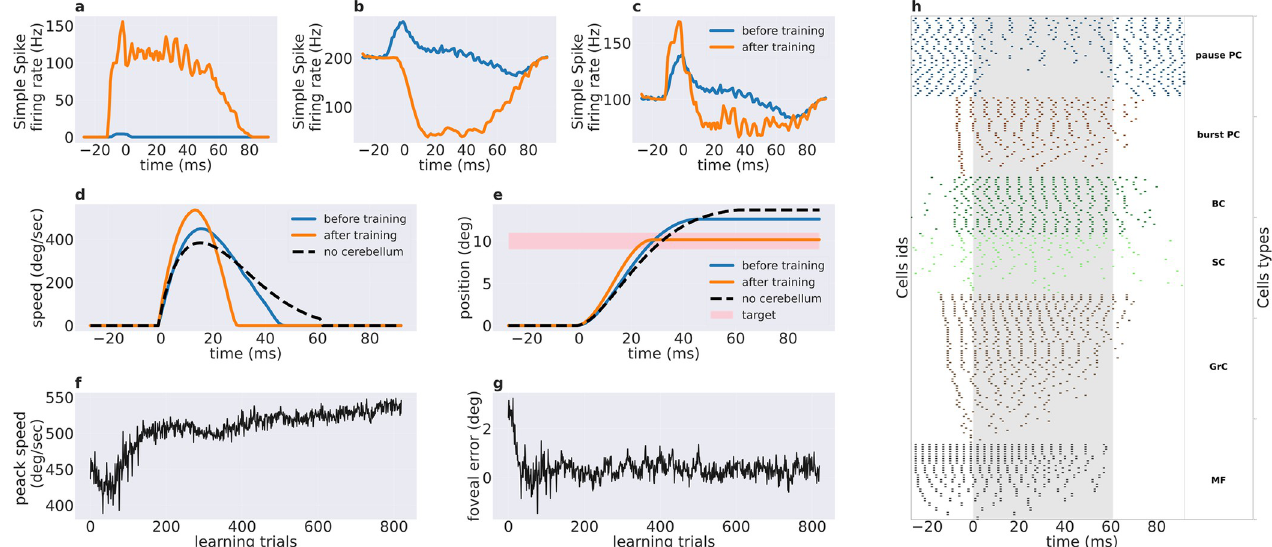
Fig 2. Effect of cerebellar learning by dual PF-PC plasticity mechanisms on the behavioral and neural variables. Simple spike firing rate: a) burst PC subpopulation. b) pause PC subpopulation, c) all PCs together. In these panels, the simple spike activity before training is shown in blue while the one after training is shown in orange. t = 0 ms corresponds to the onset of the eye movement. Eye movement kinematics: d) saccade speed and e) displacement of the eye model before training, after training and without cerebellum in blue, orange, and dashed-black. The pink rectangle represents the target within accuracy limits of +-0.5 degree. t = 0 ms corresponds to the onset of the eye movement. Movement properties across trials: f) Peak speed, g) end foveal error. h) Raster plot of the spiking activity of all cerebellar neuron populations in the model. The dots correspond to a single spike of the given cell, where the cell type is denoted in the right column. The eye movement starts at t = 0 ms and the gray box highlights the extent of movement after training. While all the pause PCs and burst PCs are shown, for the other populations only the cells that spike the most during the trial are shown.